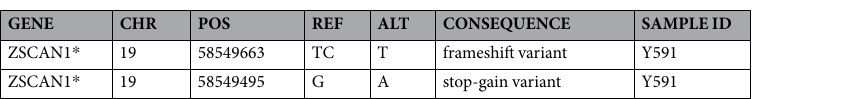
Table 4. Putative recessive loss of function candidate gene with two rare protein disruptive variants.CHR and POS show the GRCh37 coordinate of the variant; the REF/ALT columns shows the reference and alternate alleles; the CONSEQUENCE is the type of the protein disruption; the SAMPLE ID column contains the sample name in which the given variant was found in a heterozygote state. * denotes gene without disease association in MalaCards and